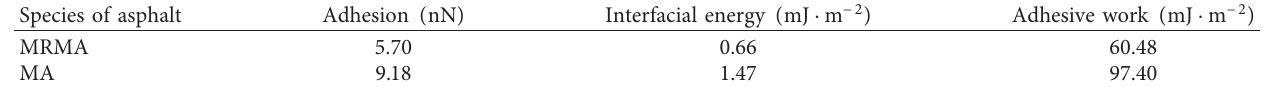
Table 7: The calculation results of the asphalt adhesion work and surface